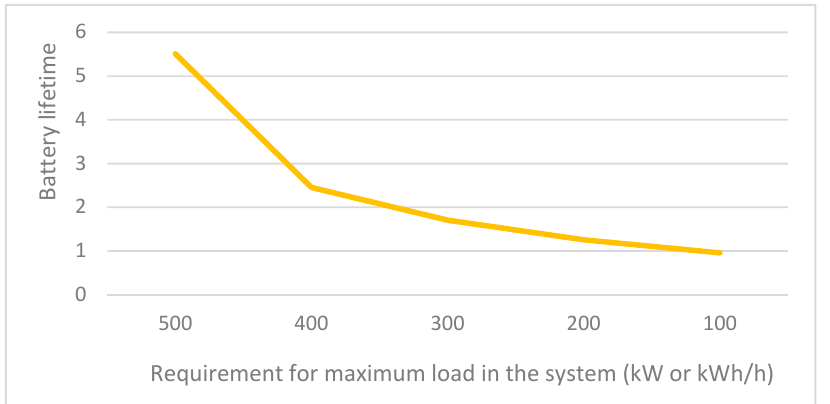
Figure 3. Reduced lifetime due to increased requirements for maximum load—consequence of increased number of charging cycles per day (as illustrated earlier in Figure 2).